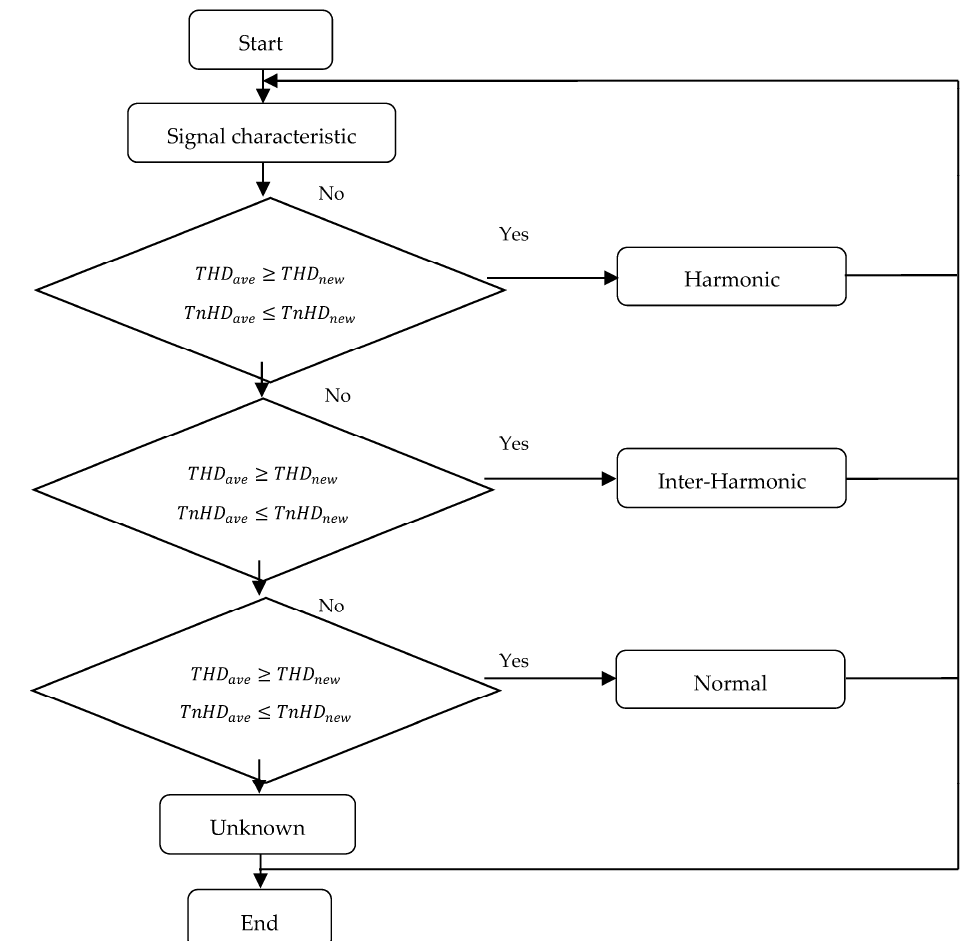
Figure 4. The rule-based classifier flow chart for harmonic signals.